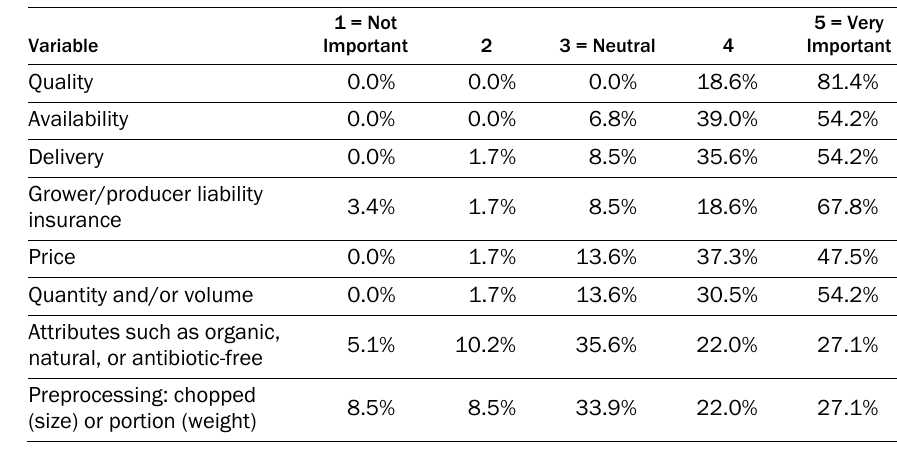
Table 10. Factors Current Users Find Most Important to Consider When Buying